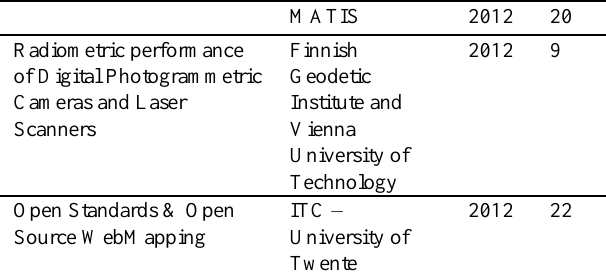
Table 2. EduServ Courses, Centres, Years Delivered